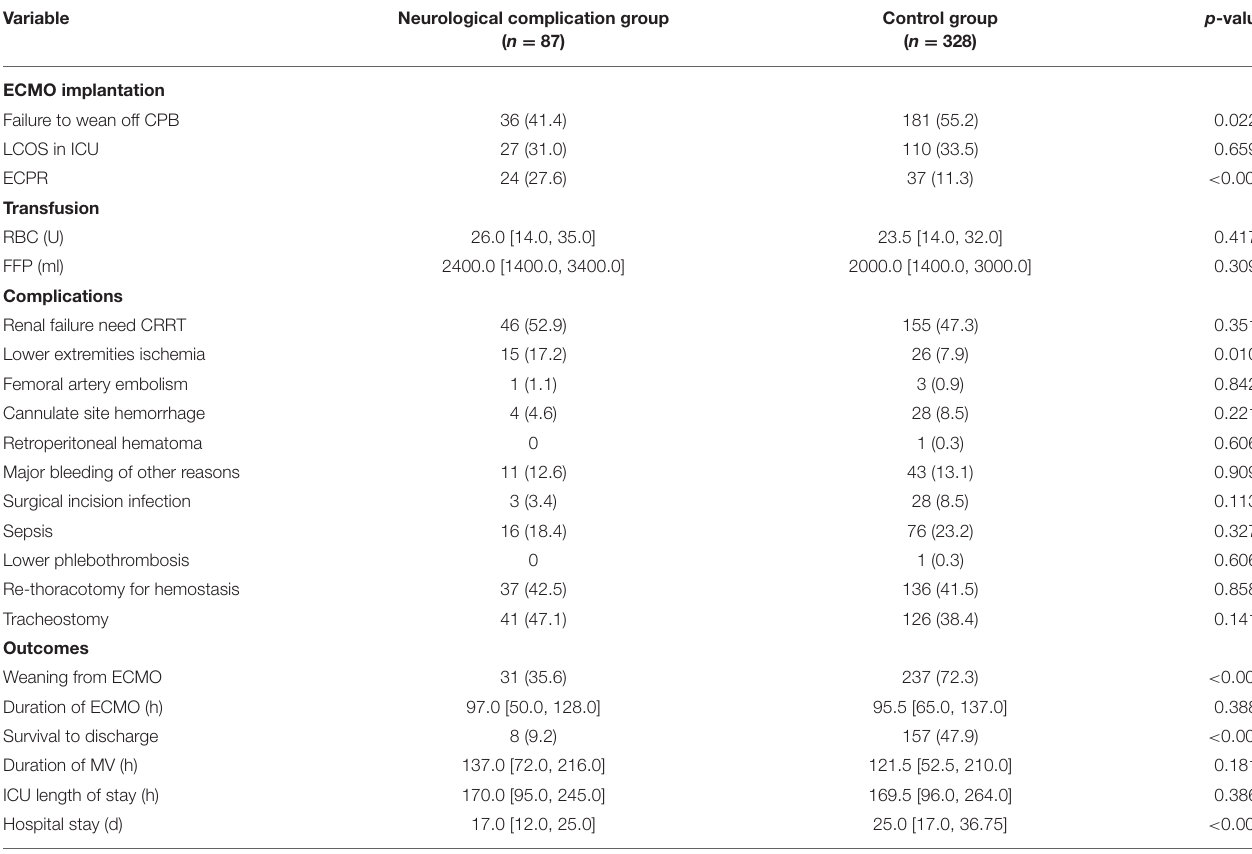
TABLE 2 | VA-ECMO indications and outcomes.